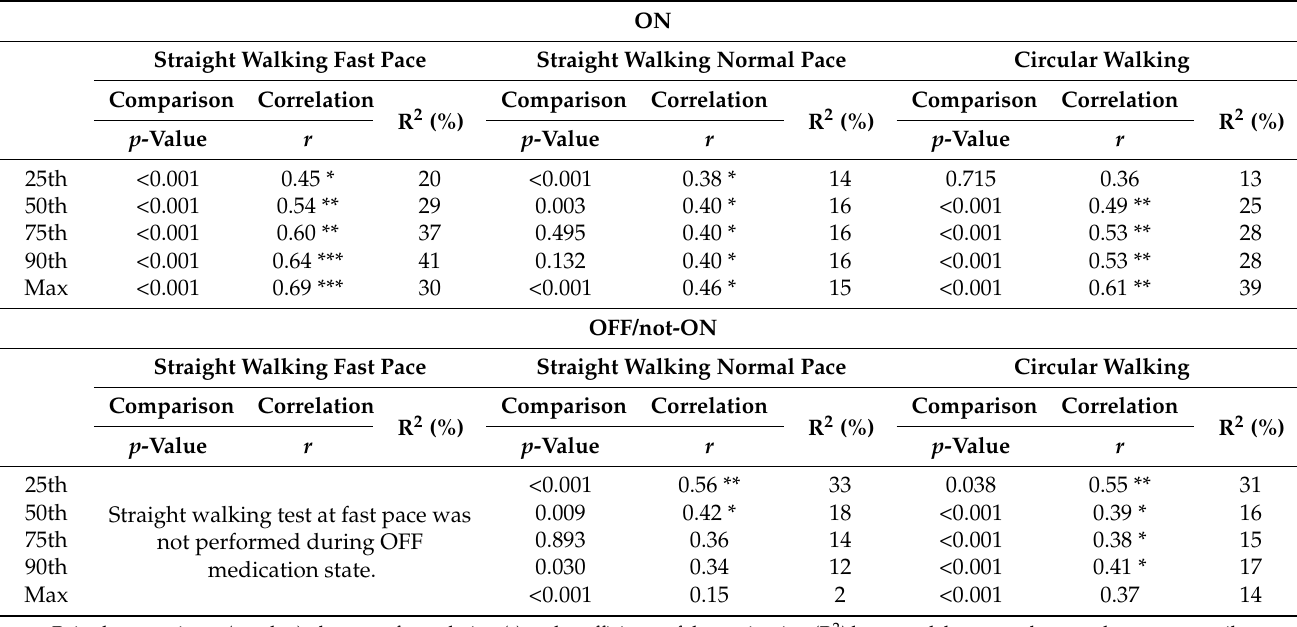
Table 2. Correlation of ON and OFF/not-ON state between the lab and the domestic environment. ON Straight Walking Fast Pace Straight Walking Normal Pace Circular Walking Comparison Correlation Comparison Correlation R 2 (%)